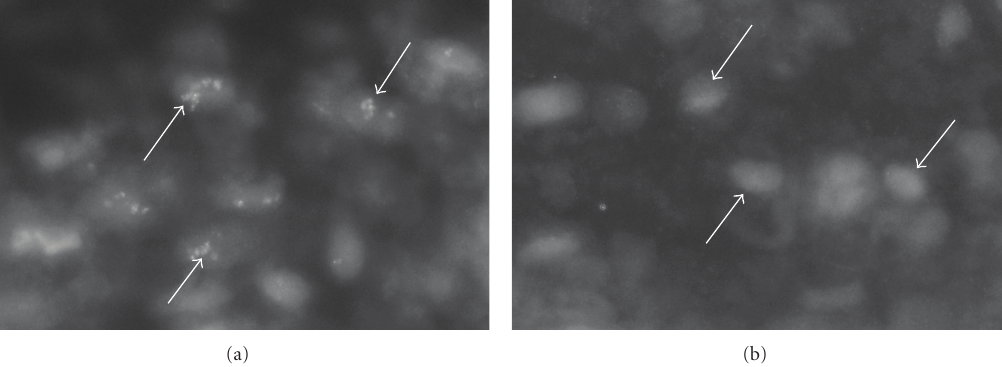
Figure 4: Sections of a myositis specimen stained for TNF-alpha (a) and for TNF-alpha after preabsorption with TNF-alpha antigen (b). The cells of an inflammatory infiltrate show immunoreactions for TNF-alpha (a) (arrows). There are no specific reactions in (b) (arrows at some of the cells).